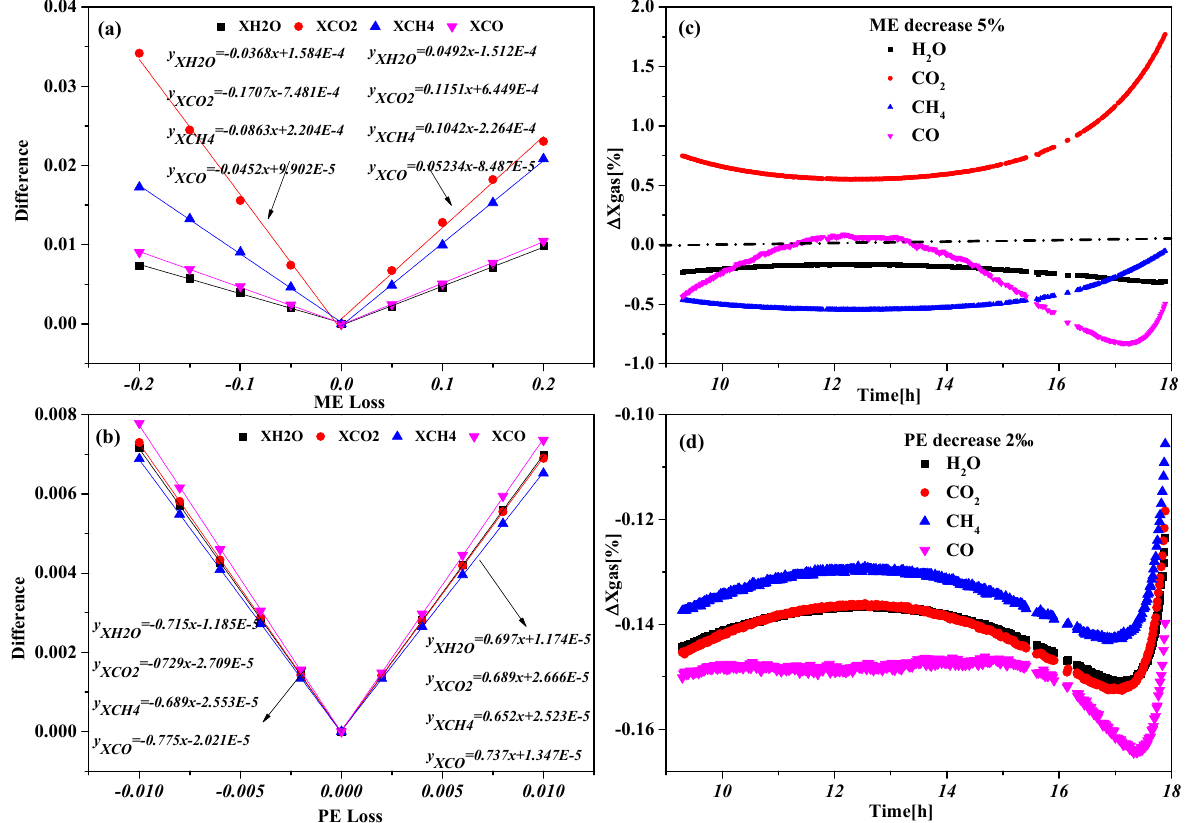
Figure 4. The e difference of XH 2 O, XCO 2 , XCH 4, and XCO with ME loss ( a ) and PE loss ( b ) with standard instrument, time series of relative difference of XH 2 O, XCO 2 , XCH 4, and XCO due to a 5% decrease of the ME values ( c ) and 2‰ rad PE values ( d ).